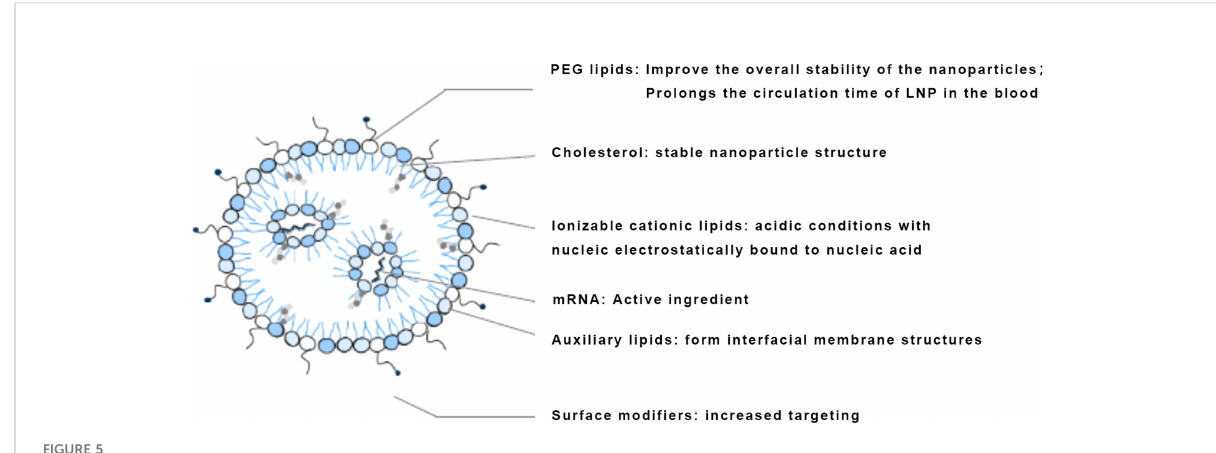
FIGURE 5 Diagram of the LNP delivery